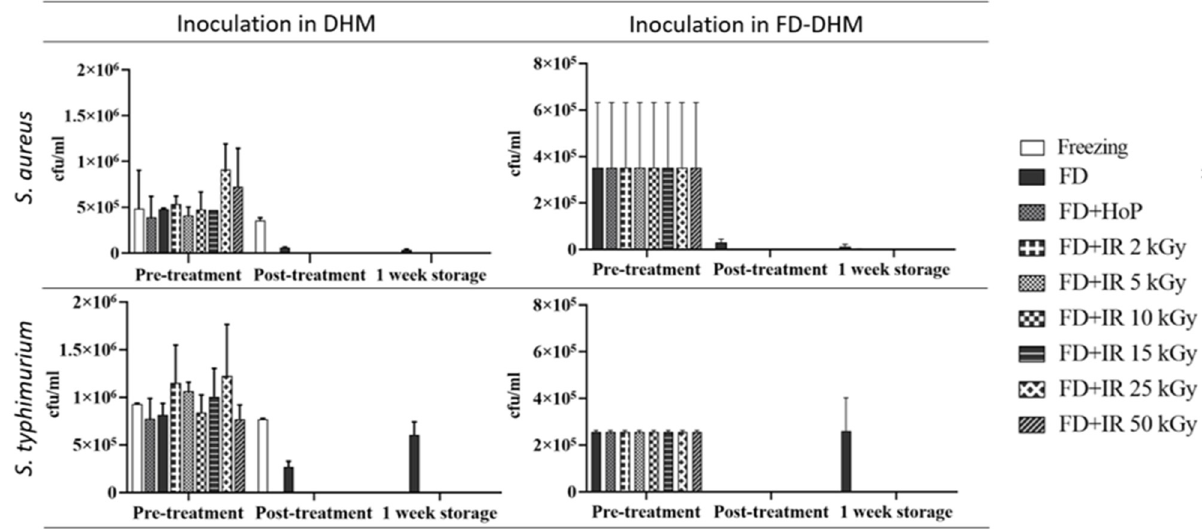
Figure 1. The effect of hybrid process (freeze-drying followed by gamma-irradiation) on the reduction of S. aureus and S. typhimurium. The column on the left shows the inoculation into liquid milk samples followed by freeze-drying and treatments. The column on the right shows inoculation on a freeze-dried DHM, prior to reconstitution, to simulate extrinsic contamination of FD-DHM powder. Values are the means ± SD of 2 technical replicates.